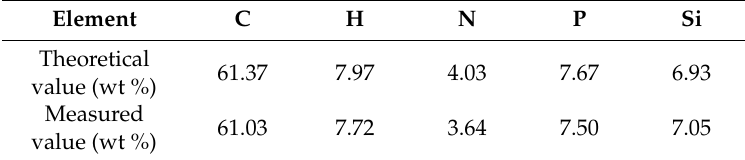
Table 2. Theoretical and measured values of the content of each element in DPES. Element C H